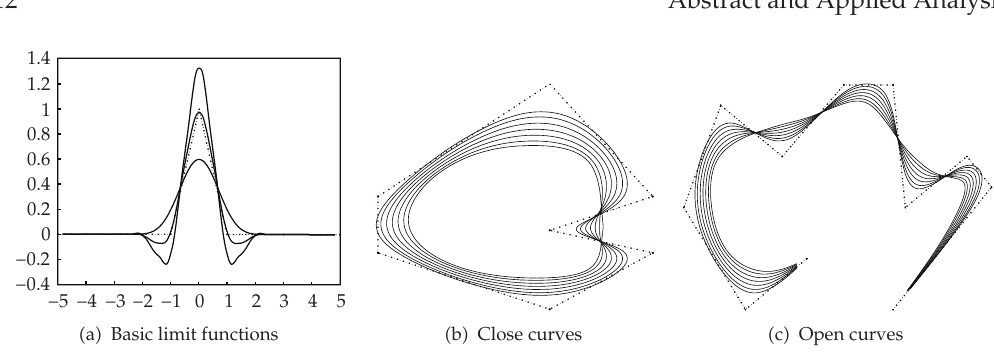
Figure 2: The e ff ect of parameter on the shape of the basic limit function/limit curve of the proposed scheme. Doted lines show control polygons; whereas solid lines indicate basic limit functions/curves. (cid:2) a (cid:3) Here, ω (cid:8) 0.75, 2.40, and 3.75 from origin to the top. (cid:2) b (cid:3) and (cid:2) c (cid:3) ω (cid:8) 1.45, 1.25, 1.00, 0.75, 0.50, 0.25, and 0.05 from left to right.